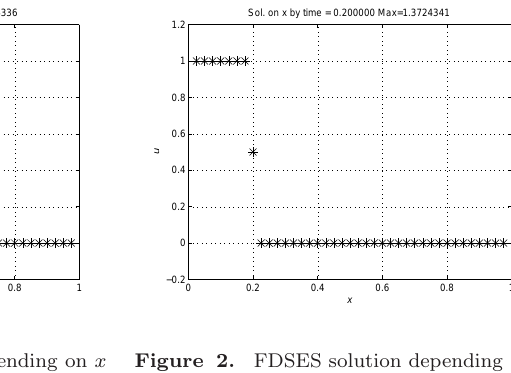
Figure 2. FDSES solution depending on x for N = 40, t = 0 .